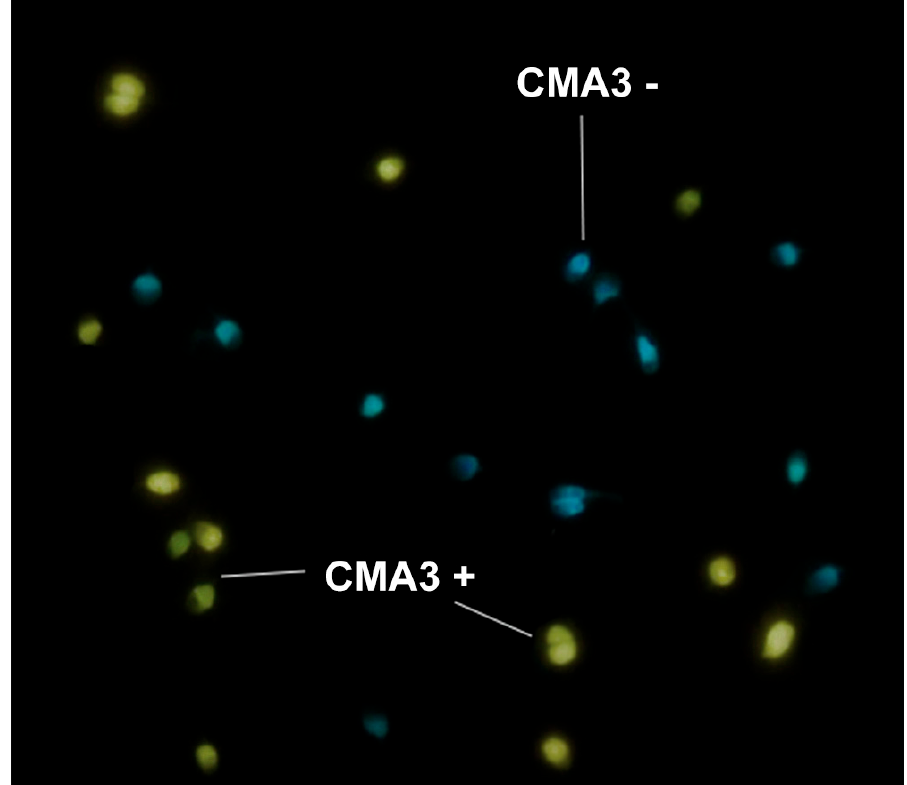
Figure 1. Sperm cells slide stained with Chromomycin A3 and counterstained with DAPI SlowFade Gold antifade. Cells with chromatin condensation deficiency are showed in yellow and normal cells in blue.